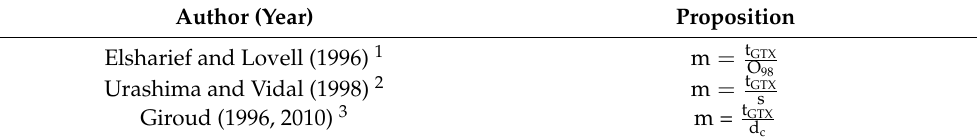
Table 7. Propositions for calculating the number of constrictions (adapted from